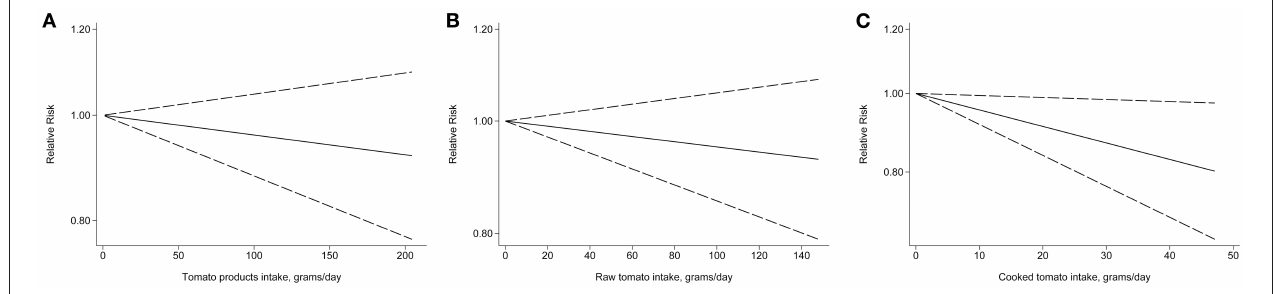
FIGURE 5 | Relative risk for prostate cancer by doses of tomato intake based on the results of the dose–response meta-analyses. Solid line represents the estimated relative risks and the dotted lines represent the 95% confidence intervals. (A) Tomato products; (B) Raw tomato; (C) Cooked